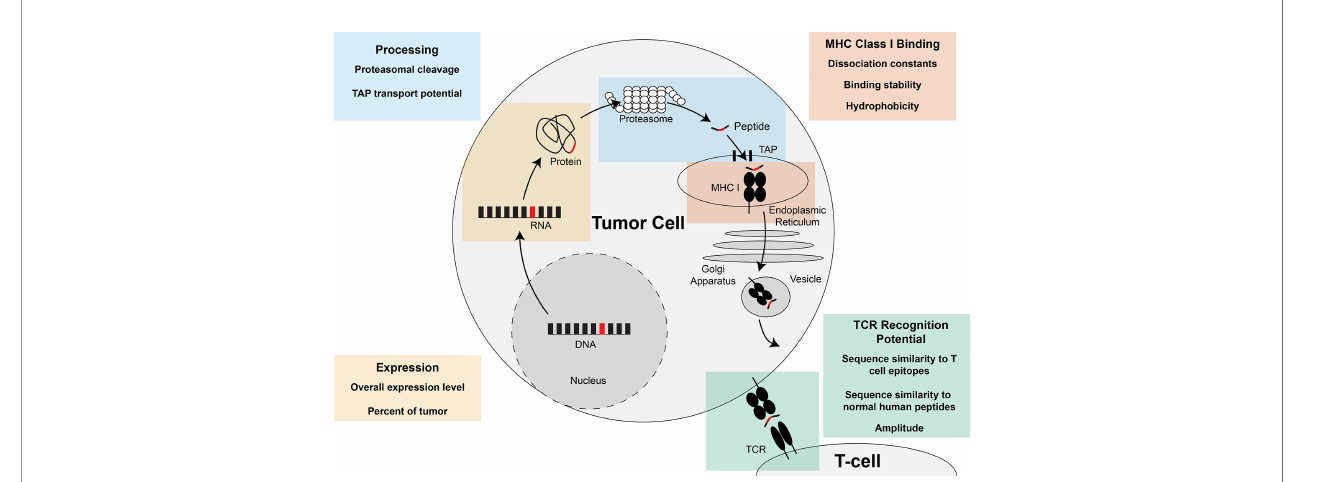
FIGURE 4 | Steps of MHC class I-restricted neoantigen prioritization and summary of characteristics considered for each step. Mutations in the DNA of a tumor cell are transcribed into RNA and translated into a protein. At the end of the life cycle of the protein, the protein is broken down into peptides by the proteasome and transported into the endoplasmic reticulum by the transporter associated with antigen presentation (TAP). Once inside the endoplasmic reticulum, the peptide has the opportunity to be loaded on MHC class I. If the peptide is successfully bound to MHC class I, the peptide:MHC complex is transported to the cell surface where the peptide:MHC complex has the opportunity to be recognized by the T cell receptor (TCR). Characteristics of the neoantigen encompassing expression, processing, MHC class I binding, and TCR recognition potential have been assessed to enhance prioritization of MHC class I-restricted neoantigens and are summarized in each of the boxes in the fi